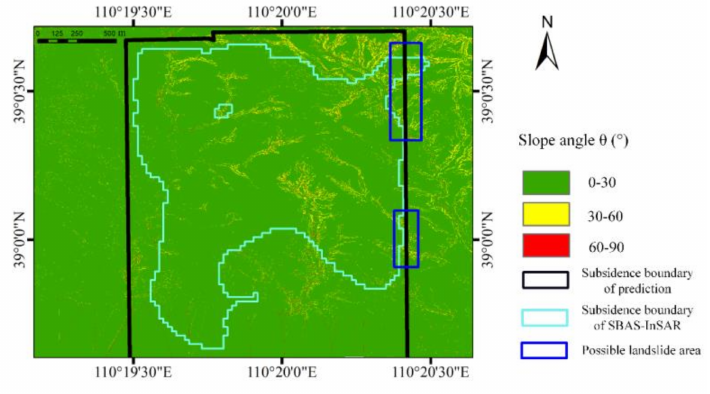
Figure 11. Slope angle of the study area.